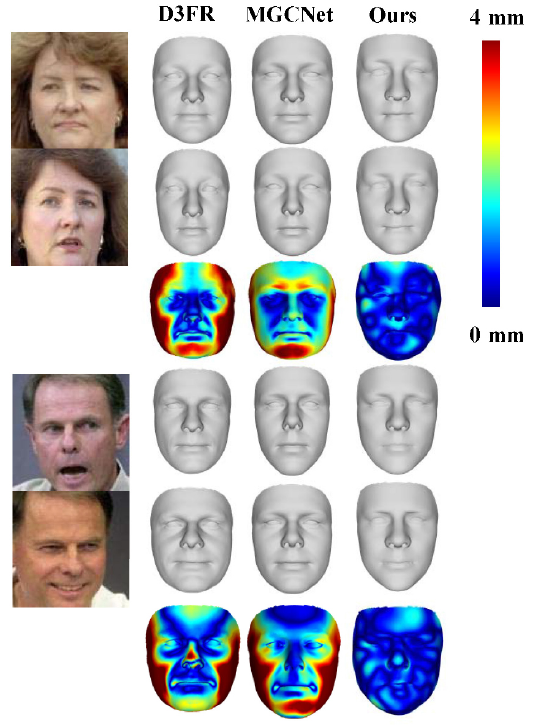
current 3D face dataset. Nevertheless, our main goal is to reconstruct the stable face from the different conditions with SFM, as shown in Fig. 10, which outperforms the previous method.